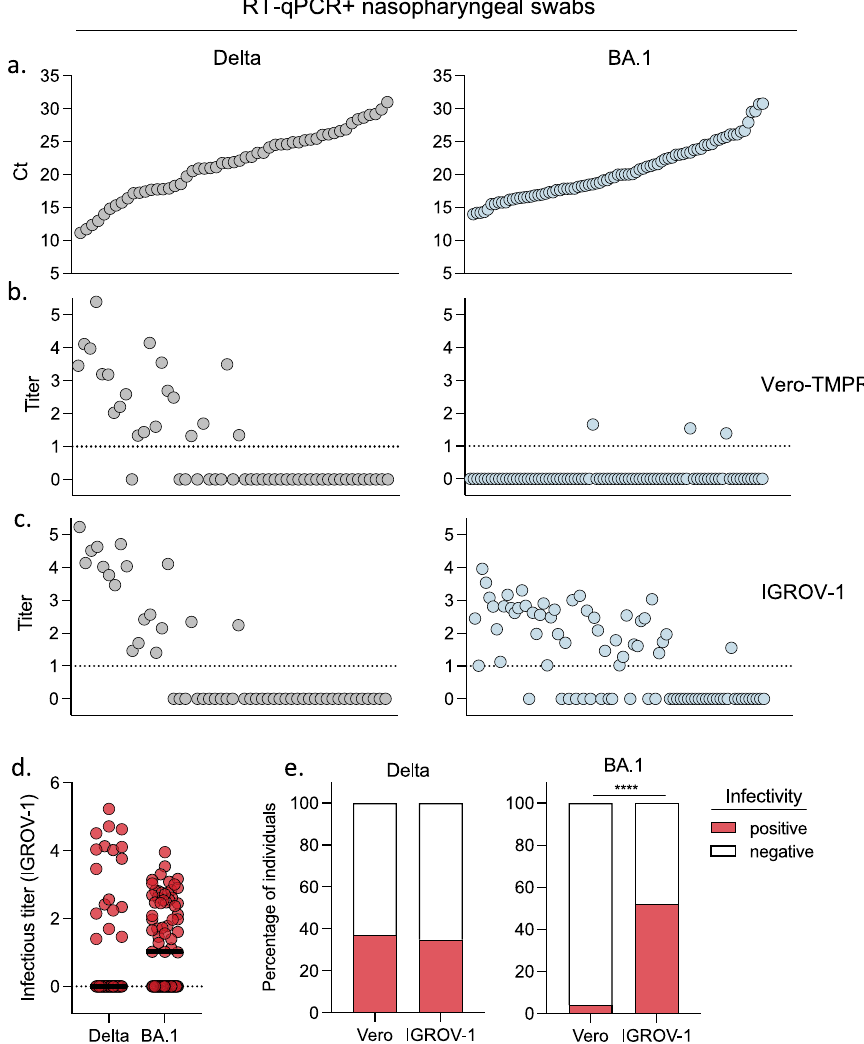
Fig. 1 | Improved detection of infectious Omicron BA.1 in nasopharyngeal swabs using IGROV-1 cells. A retrospective series of 135 RT+qPCR+ nasophar- yngeal swabs from COVID-19 patients, harboring Delta ( n =53) or Omicron BA.1 ( n =82) variants was collected. a Viral RNA loads, measured by RT-qPCR. The samples were ranked from high to low viral RNA load (low to high Ct). Viral titers were measured in Vero-TMPRSS2 ( b ) and IGROV-1 cells ( c ). Delta and Omicron